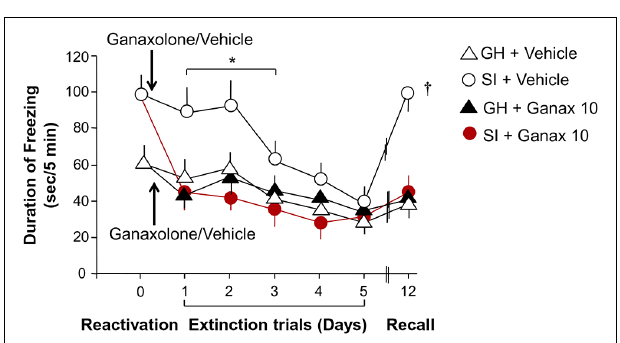
FIGURE 5 | Ganaxolone facilitates fear extinction and blocks contextual fear reconsolidation. SI mice (empty circles) exhibit increased freezing and reduced extinction compared to group-housed mice over a period of five extinction trials. Ganaxolone treatment administered immediately after a reactivation session (black arrow) compared to vehicle treatment resulted in less freezing in the SI mice (red circles). Ganaxolone did not affect freezing time in the group-housed mice (black triangle). Importantly, ganaxolone prevented the spontaneous reemergence of contextual fear responses after the passage of time – or from another perspective, enhanced extinction retention in SI mice. Data represent the mean ± SEM of 10–12 mice. * P = 0.035 when compared to SI + Ganaxolone; † P = 0.025 when compared to SI + ganaxolone on recall (day 12).